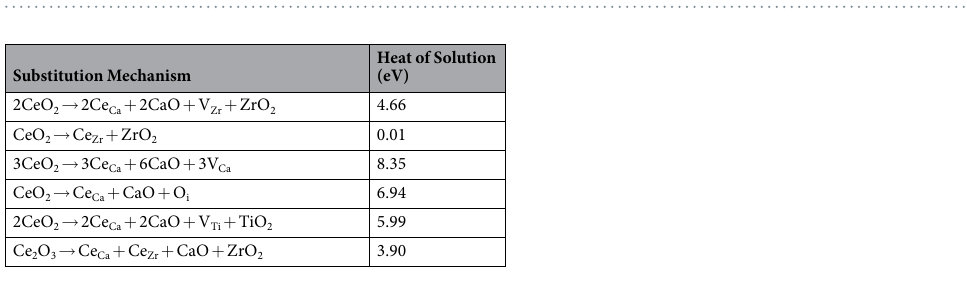
Table 4. Possible substitution mechanisms for Ce incorporation into